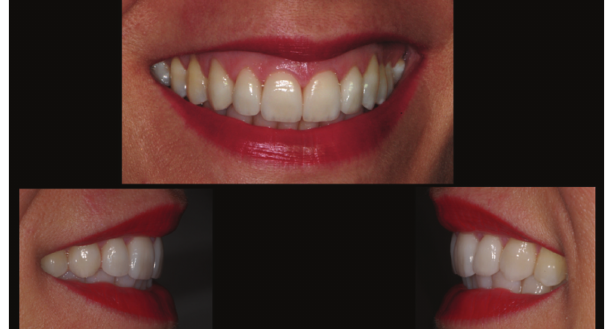
Figure 9: Case 2 (Bilayered Lithium Disilicate Veneer Replace- ment). The patient’s